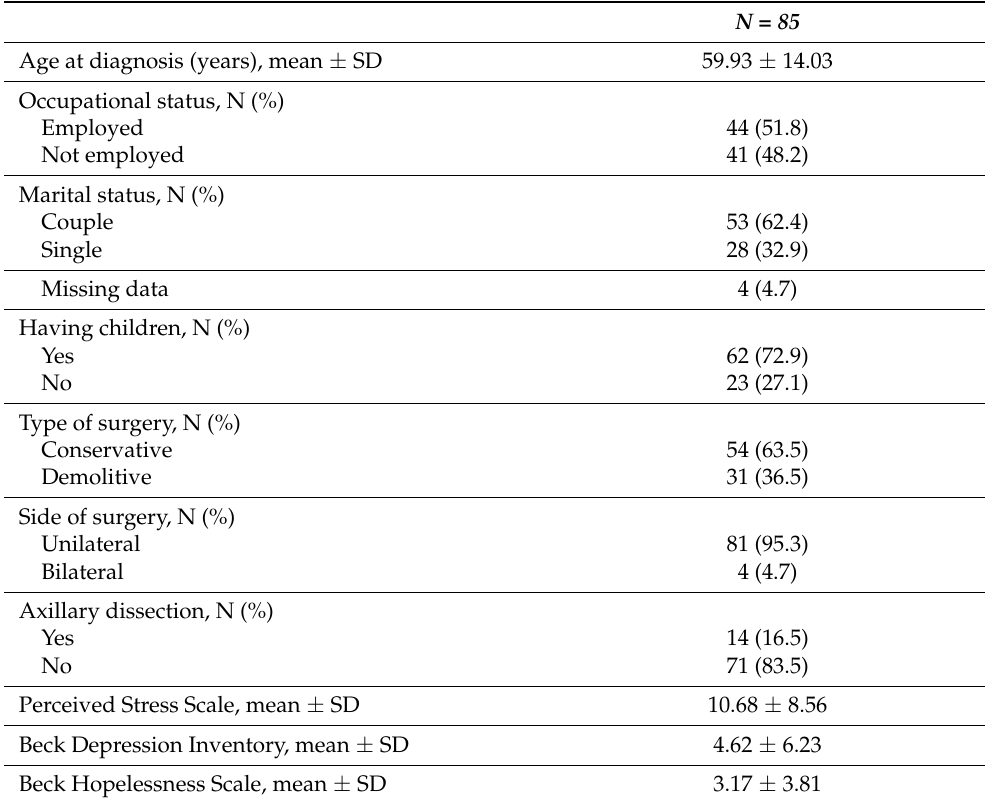
Table 1. Sociodemographic and clinical characteristics of the sample.